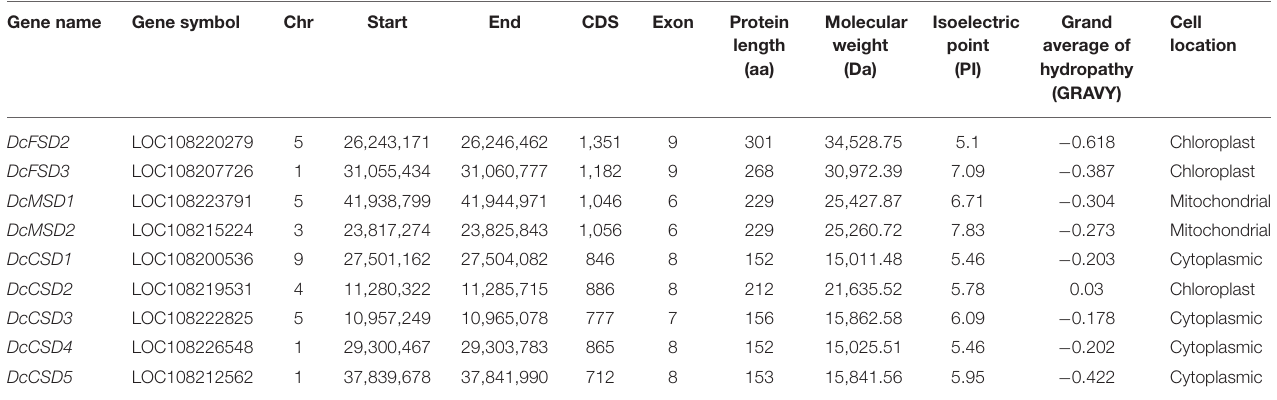
TABLE 1 | Features of SOD genes in Daucus carota